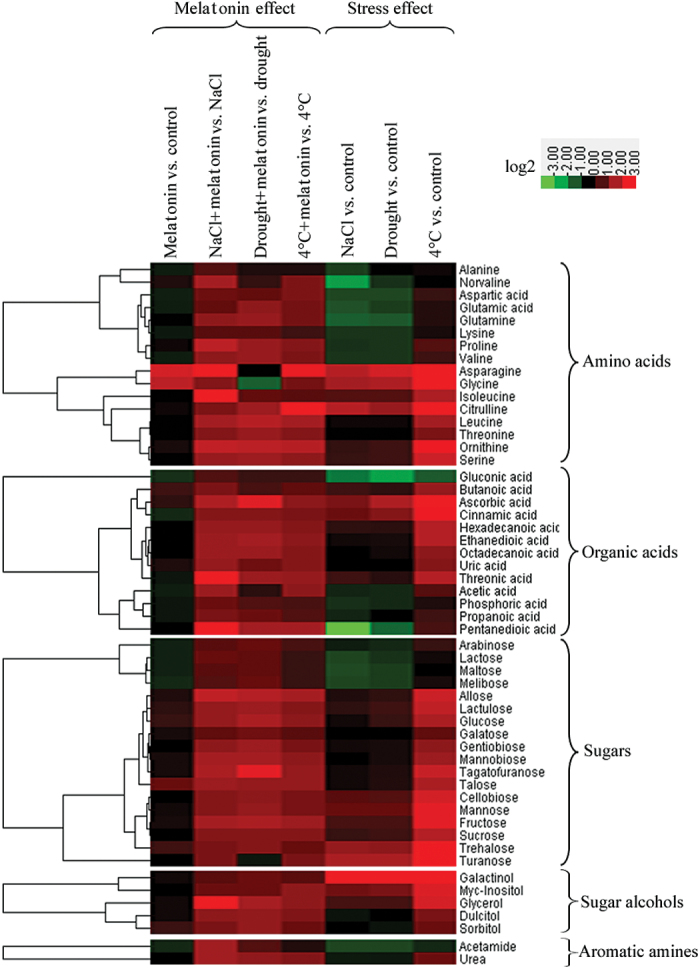
Hierarchical cluster analysis of metabolites modulated by exogenous melatonin in bermudagrass response to abiotic stress. Hierarchical cluster analysis of 54 metabolites of 28-day-old plants by melatonin effect (melatonin versus control, NaCl+melatonin versus NaCl, drought+melatonin versus drought, 4 °C+melatonin versus 4c°C) and by stress effect (NaCl versus control, drought versus control, 4 °C versus control). The log2 ratios and scale bars are shown in the resulting tree figure, which was obtained using the CLUSTER software package and the Java Treeview. The concentrations of these metabolites are listed in Supplementary Table S2 at JXB online. (This figure is available in colour at JXB online.)